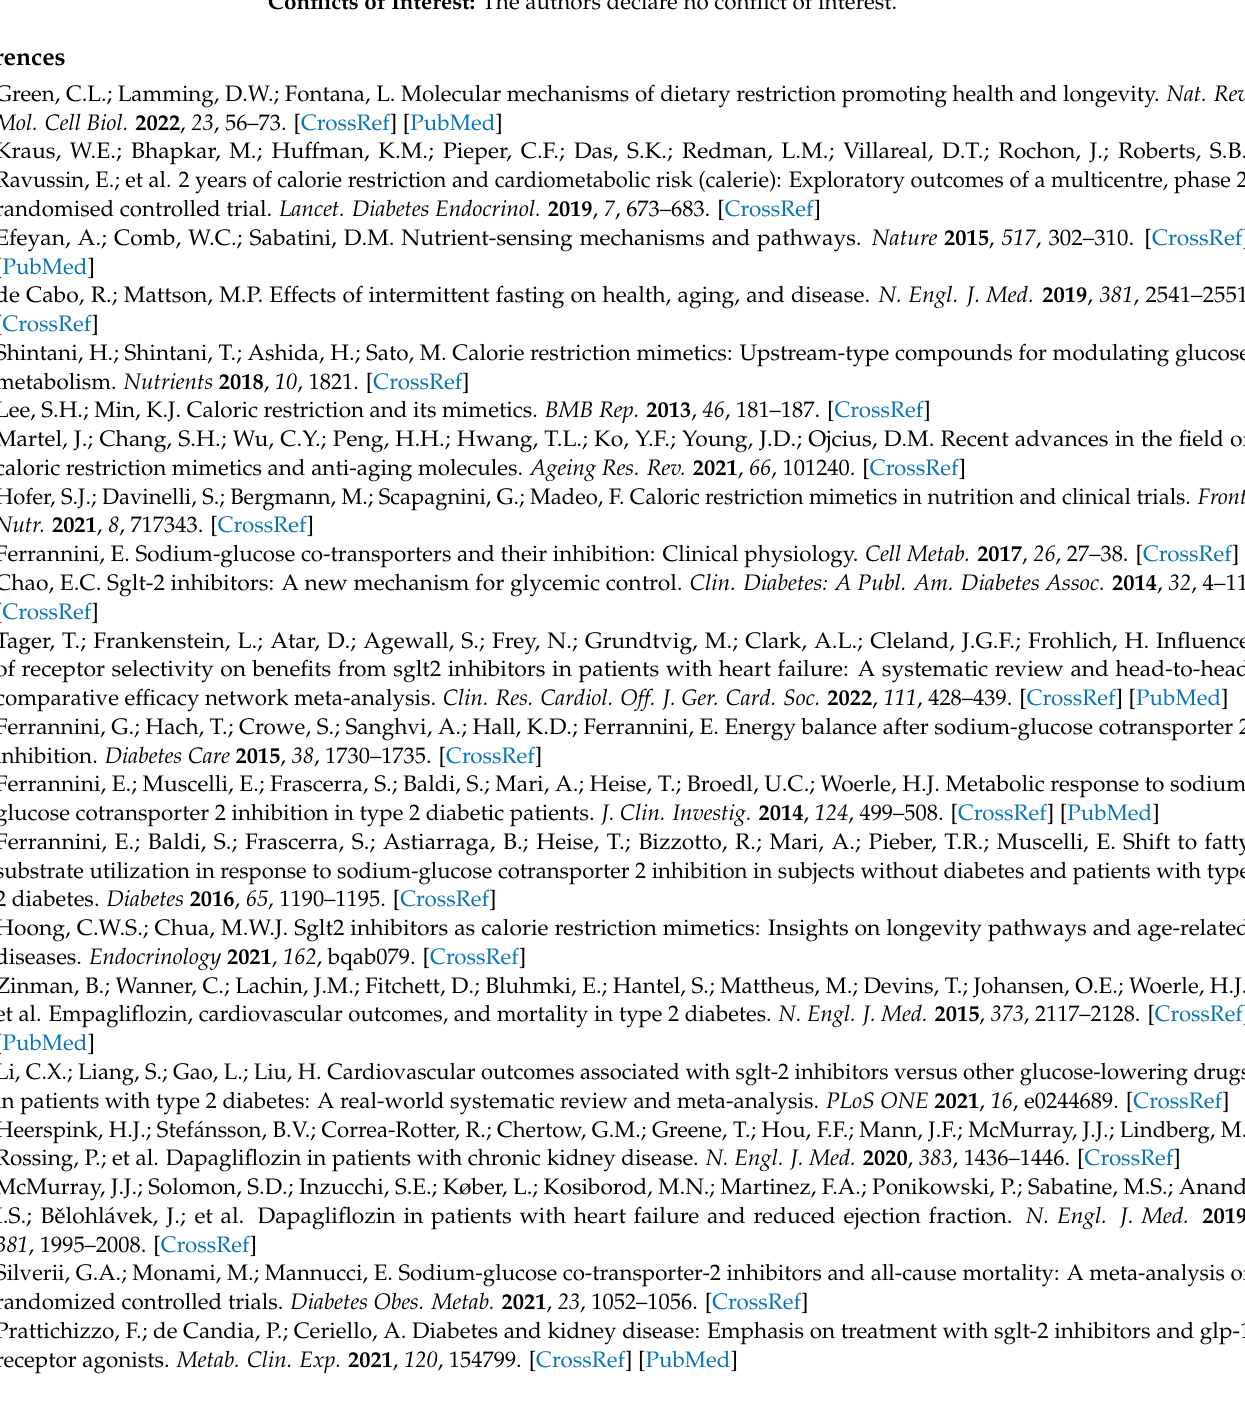
figure. G.M. and P.d.C. implemented the paragraphs relative to the pathways modulated by